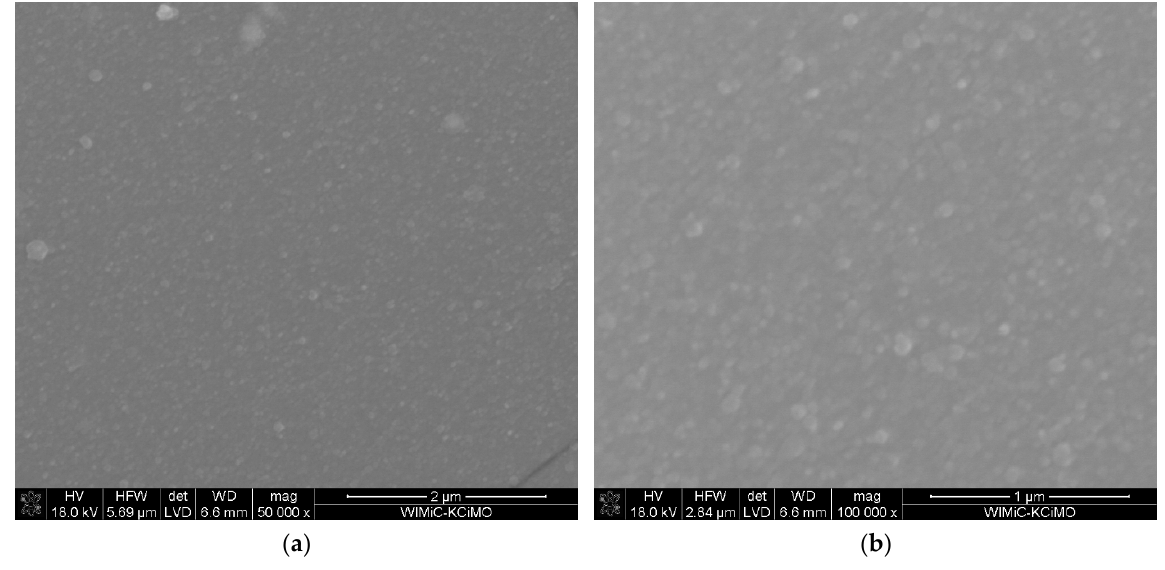
Figure 1. Microstructure of the layer deposited at temperature of 600 °C on tubular substrate at different magnifications: 50,000× ( a) and 100,000× ( b ). The content of Sc(tmhd) 3 in the gas mixture: 14 mol.%. Total gas pressure: 6580 Pa. Synthesis time: 20 min.